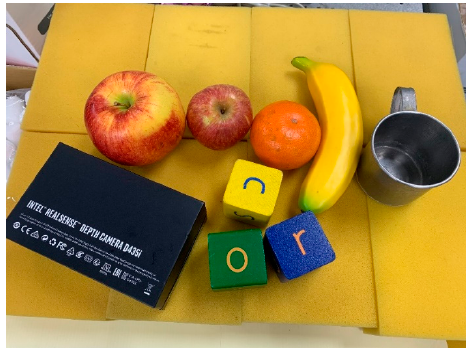
Figure 9. Objects of interest used in the experiment.